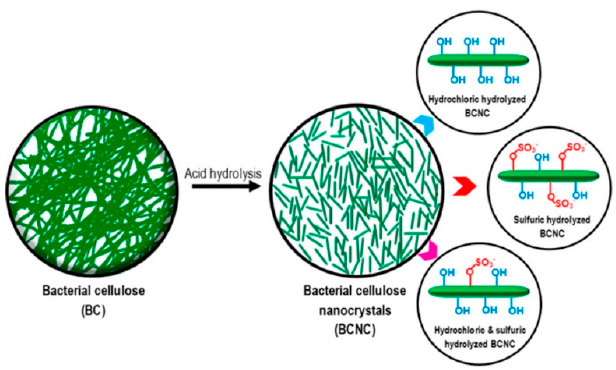
Figure 4. Diagram of bacterial cellulose nanocrystals (BCNCs) produced from BC by acid hydrolysis with diverse kinds of acid. Reprinted with permission from Ref. [66]. Copyright 2018 American Chemical Society.